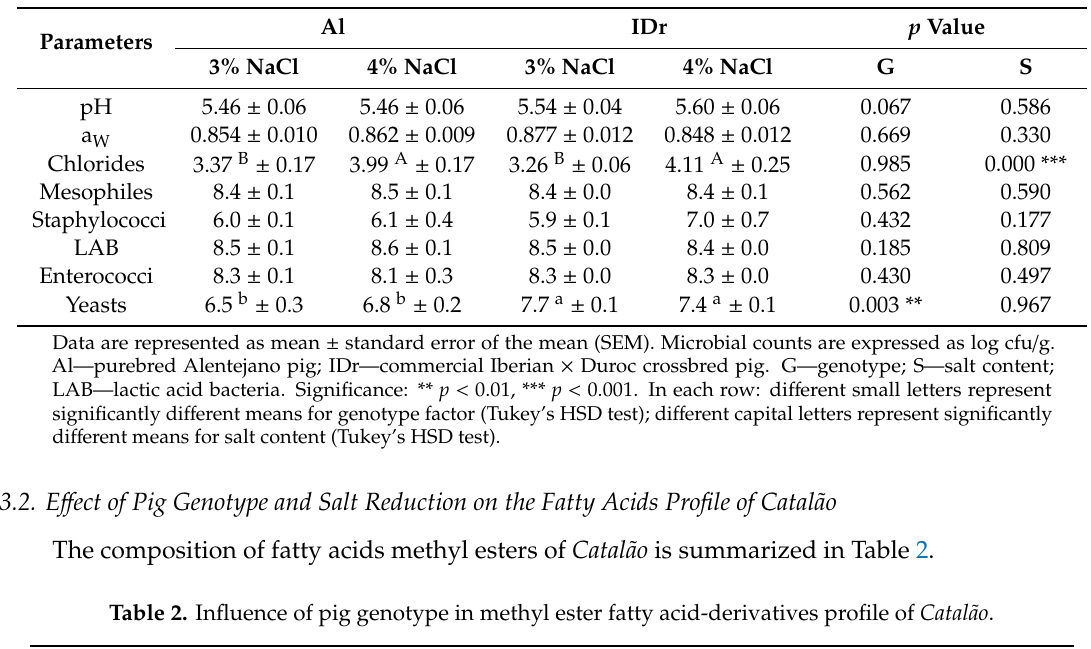
Table 1. Influence of pig genotype and salt content (% NaCl) in physicochemical parameters and microbial counts of Catal ã o .